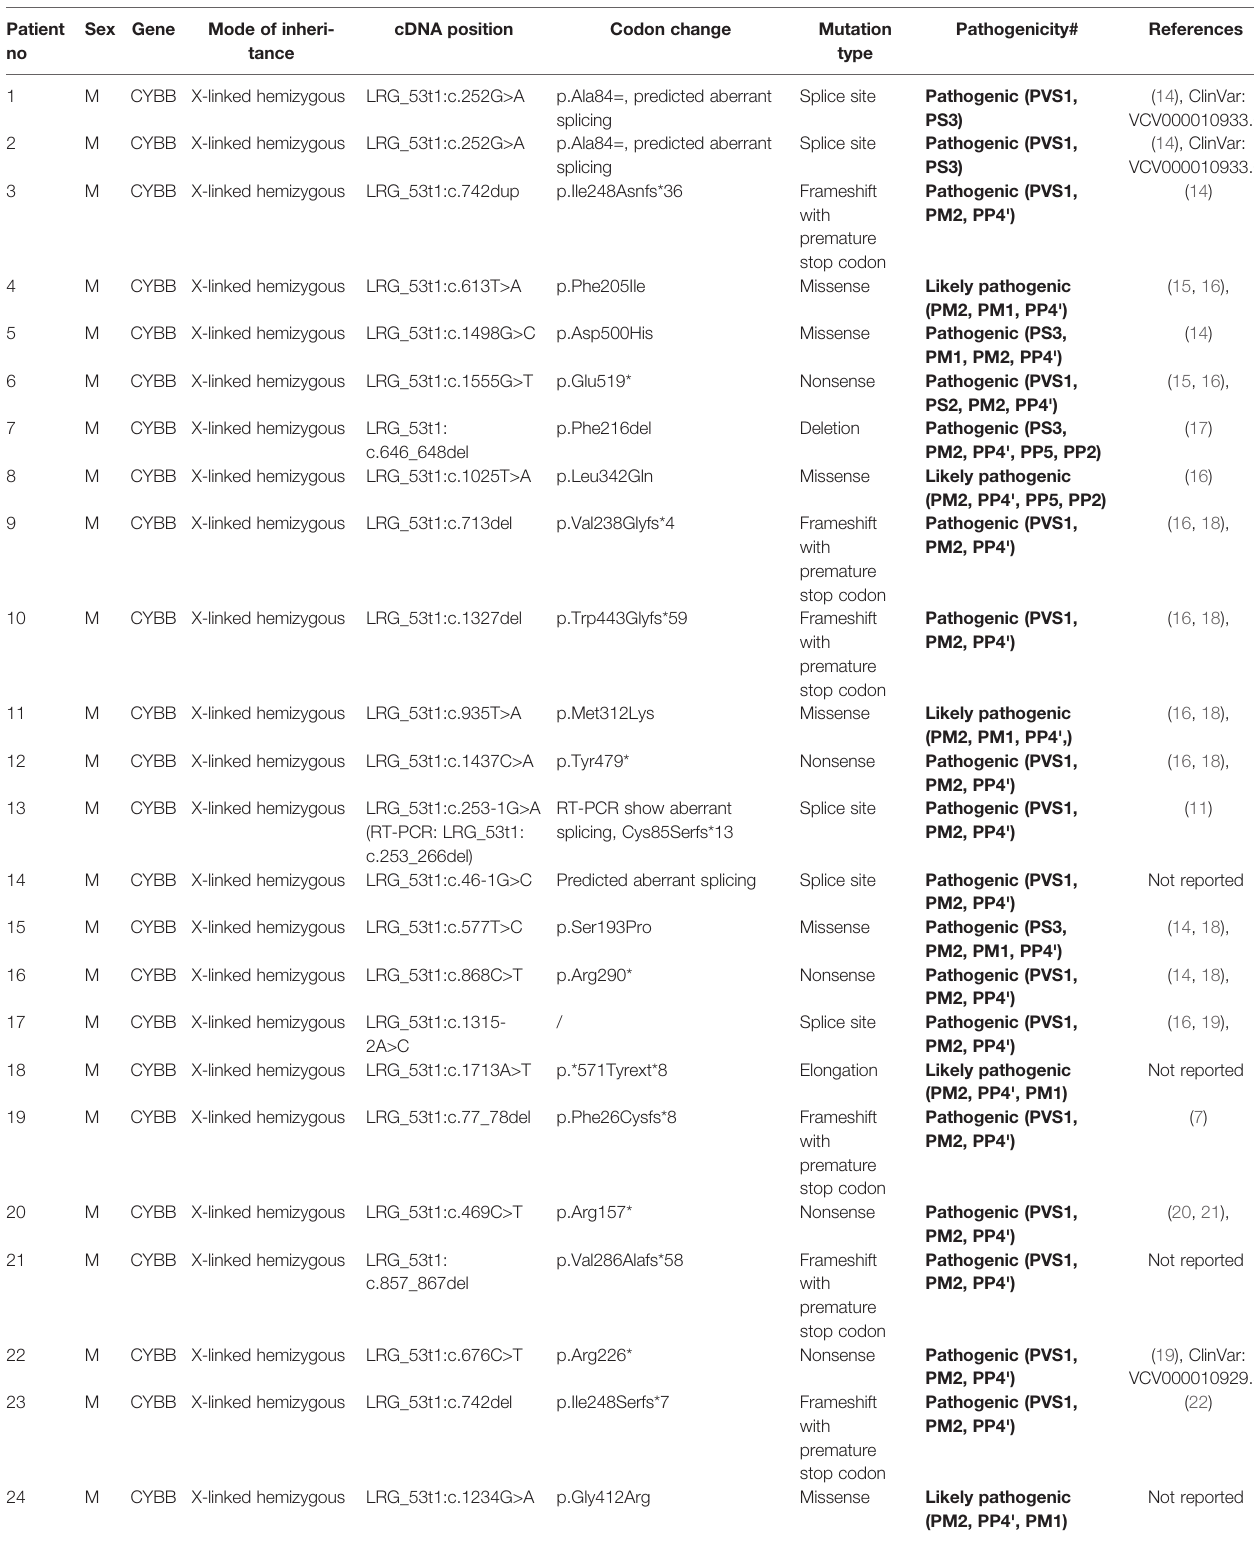
TABLE 1 | Genetics data of CGD patients. Patient